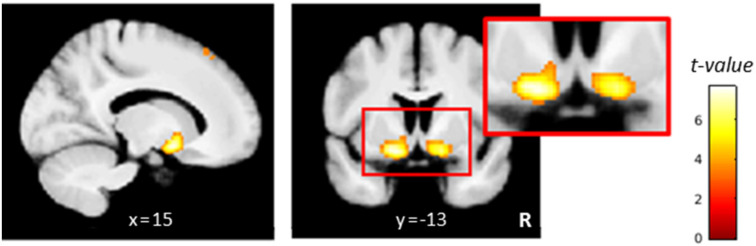
Striatal coding of the model-based prediction error (PE).Activity in the bilateral ventral striatum correlated positively with the PE signal. For visualization purposes thresholded at p<0.001, uncorrected. R: right.